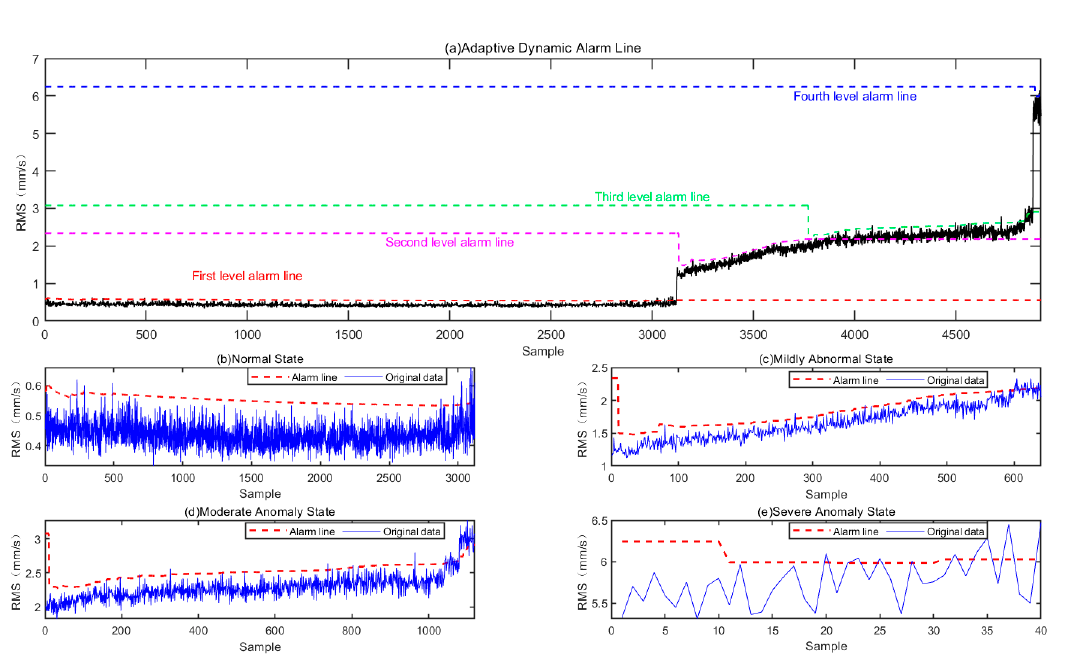
Figure 9. Comparison of the different threshold methods (normal state).